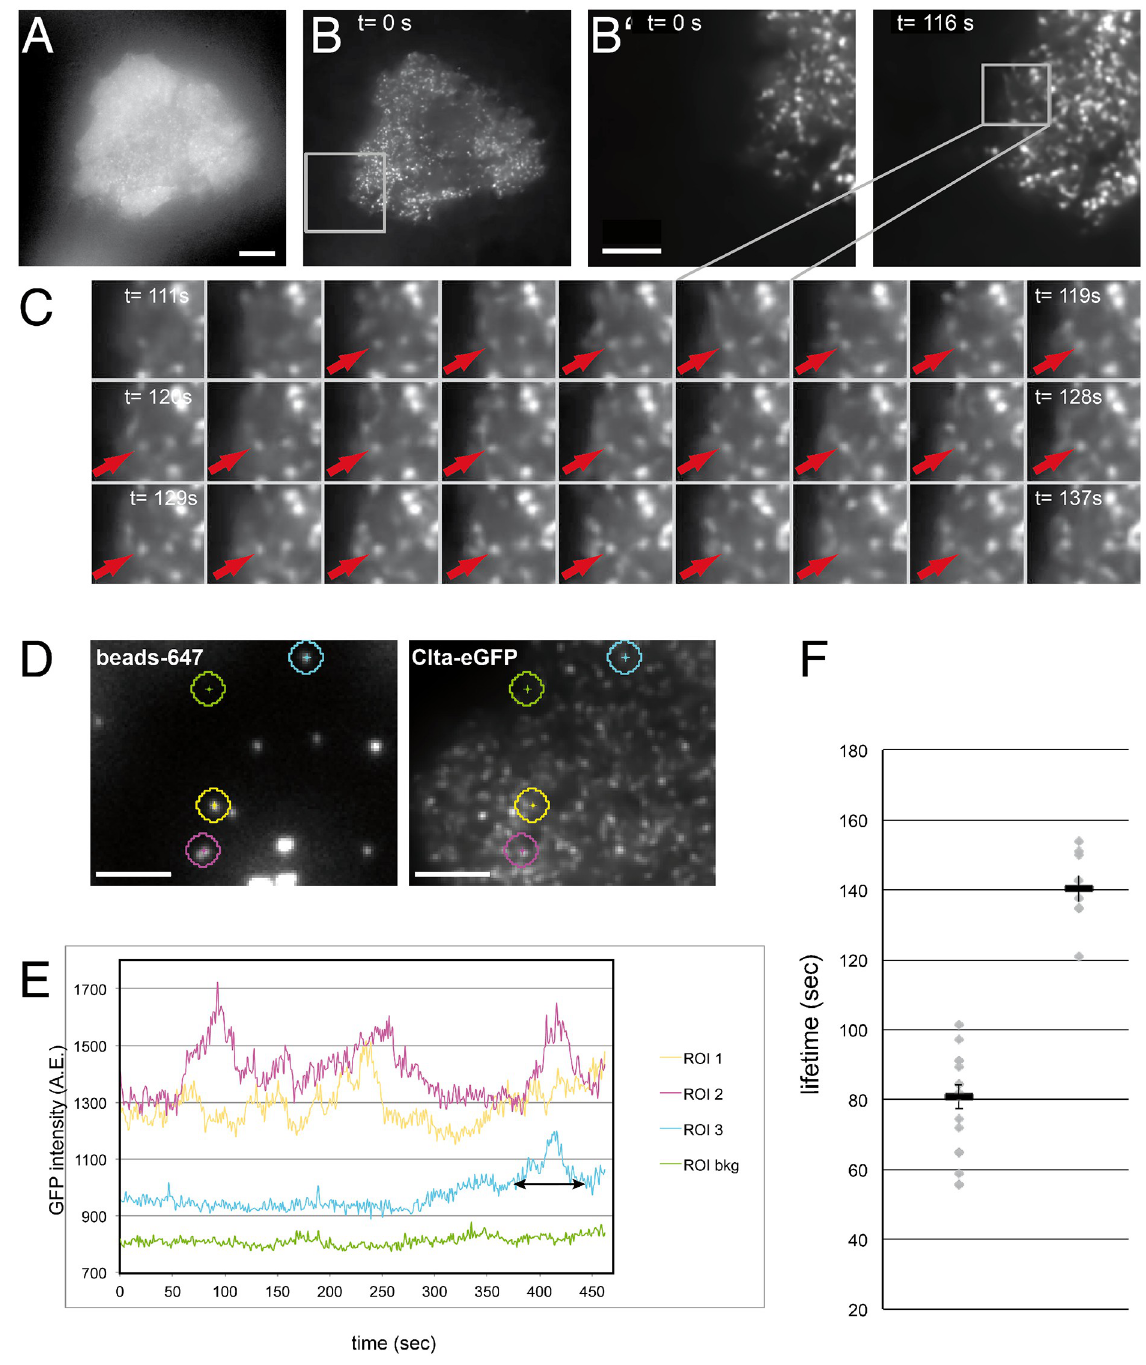
Fig 5. Clta-eGFP dynamics and recruitment to immobilized beads. MEFs from Clta-eGFP mice show dynamic puncta consistent with Clta- eGFP localization at coated pits and coated vesicles. ( A-C ) Clta-eGFP expressing cell imaged by wide field fluorescence ( A ) and TIRFM ( B , C ). The cell was imaged at 1 fps for 3 minutes. In ( B’ ) the region indicated in ( B ) is magnified for the indicated times to show the temporal changes of Clta-eGFP puncta. ( C ) Time lapse of a 5 μ m region indicated in B’ where a Clta-eGFP spot appears (arrow) and loses intensity before disappearing at t = 137 s. ( D-F ) Recruitment of Clta-eGFP to immobilized beads. ( D ) TIRF imaging of beads and Clta-eGFP ( E ) Representative analysis of Clta-eGFP intensity at beads (ROI 1–3) over time and in a control region (green, background bkg). Note that the regions shown in ( D ) have been enlarged for clarity, regions analyzed only comprised 12 pixels (0,41 μ m 2 ). The time of elevated GFP intensity is indicated as “lifetime”, e.g. as for ROI3 (cyan) where Clta-eGFP was recruited at the end of the time lapse. ( F ) Clta-eGFP lifetimes collected from 6 cells on beads. Lifetimes measured clustered around 81.0 seconds and 140.5 seconds (median of values), error bars indicate standard mean error. Scale bars are A = 10 μ m, B’, D = 5 μ m.